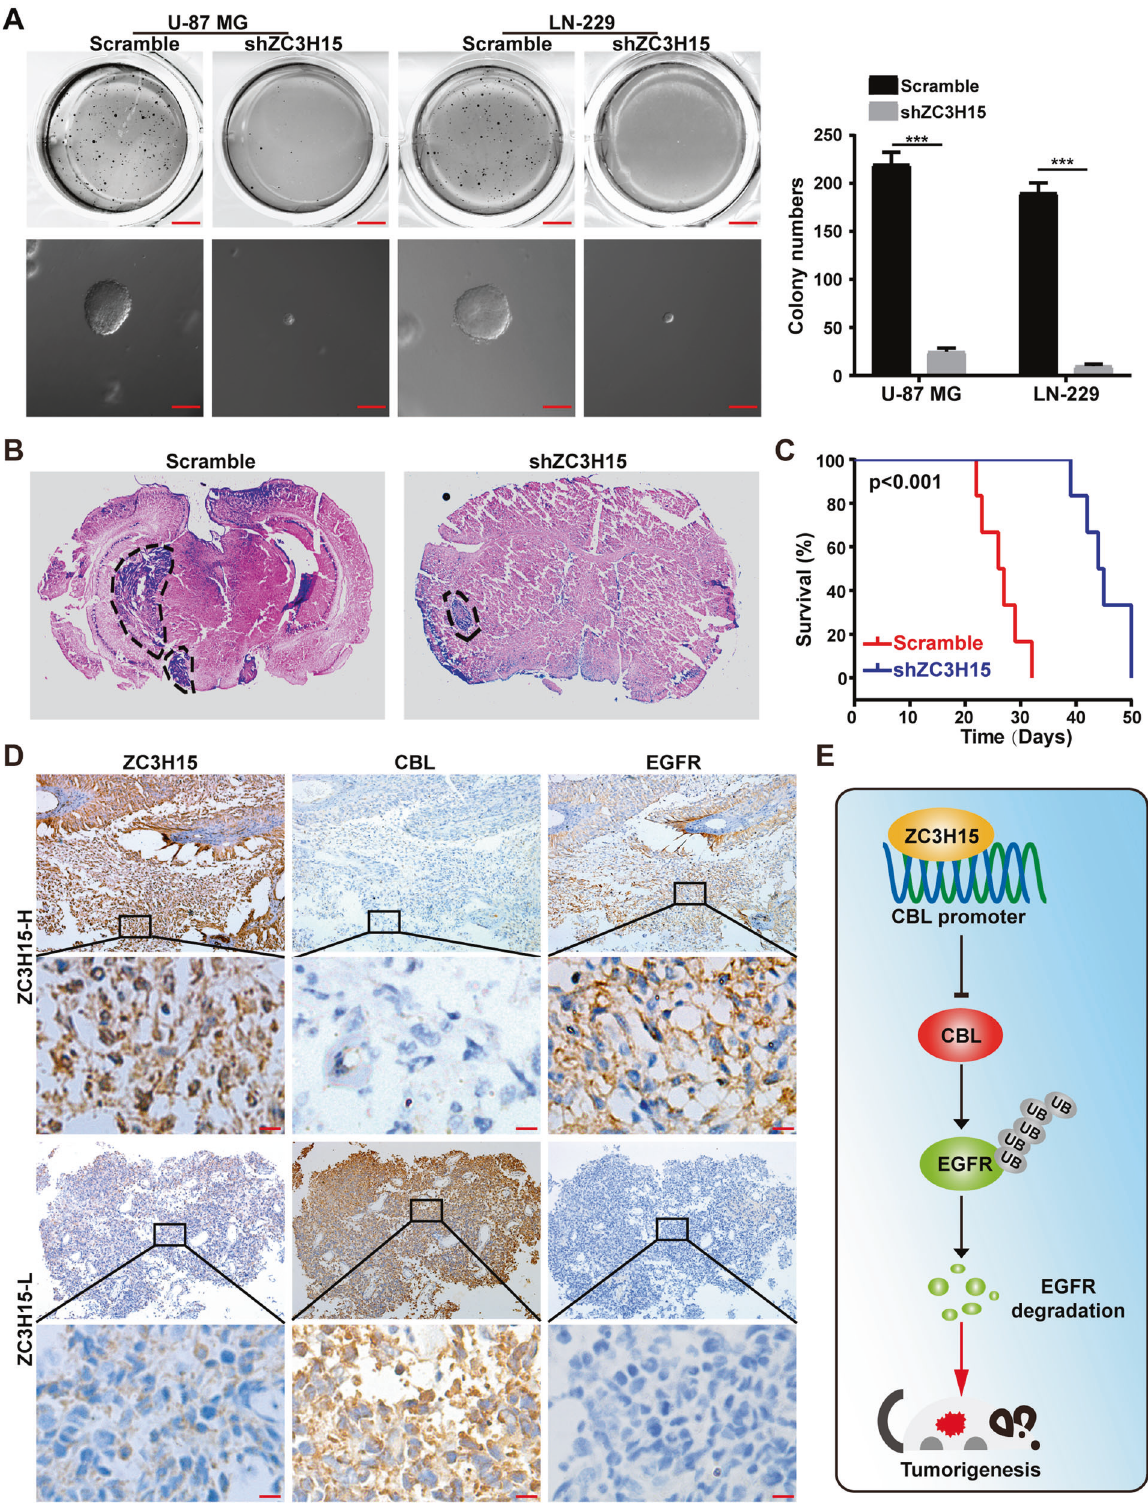
Fig. 6 ZC3H15 knockdown inhibits tumor growth and improved prognosis in mice. A The colony formation ability of GBM cells was detected by soft agar assay. B Orthotopic implantation experiment was performed to assess the in vivo tumor formation capabilities of ZC3H15-knockdown and control cells. C The survival curve of mice was plotted based on the living days of mice after the in-situ injection. D The expression levels of ZC3H15, CBL, and EGFR were stained and showed in the representative section of tumor samples of GBM patients. ZC3H15-H, ZC3H15 high expression; ZC3H15-L: ZC3H15 low expression. E Model of the impact of the ZC3H15 on regulating cell proliferation, migration, invasion, and tumorigenesis of GBM cells. The data were expressed as mean ± SD. Student ’ s t test was performed to analyzed signi fi cance. * P < 0.05, ** P < 0.01, *** P < 0.001.